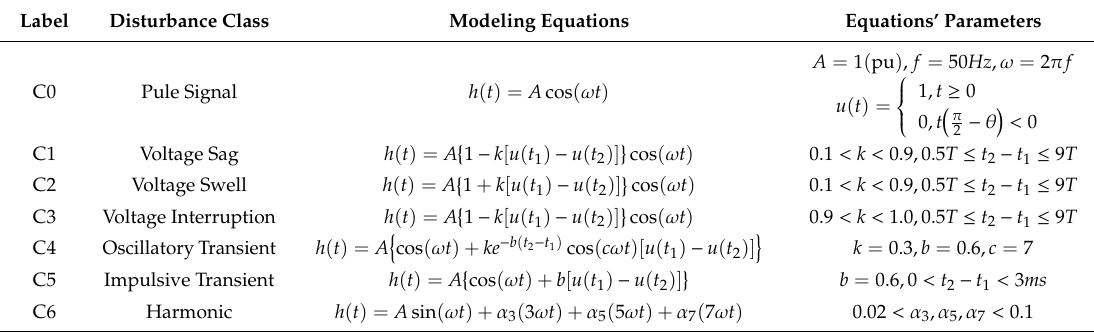
Table 1. Power quality disturbances models and its controlling